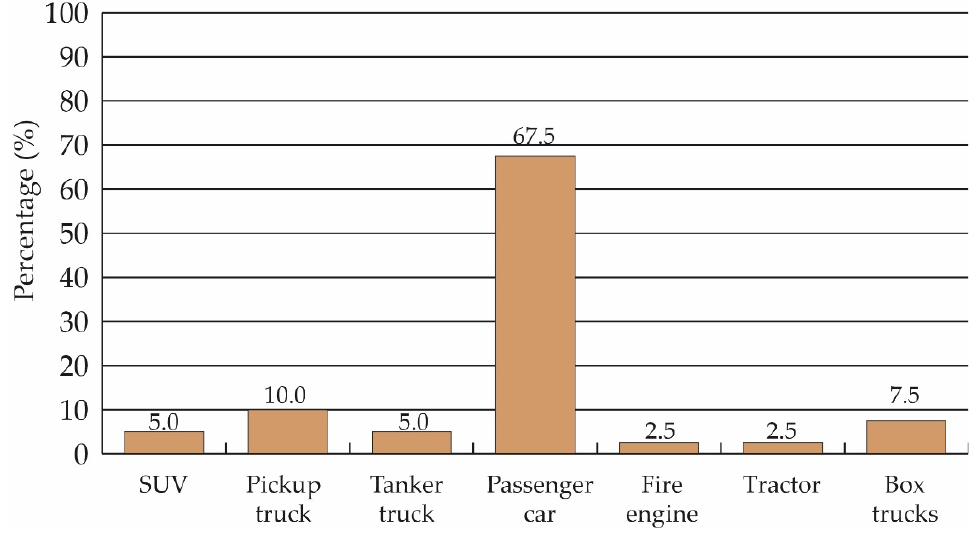
Figure 4. Distribution of studied cases per vehicle type.